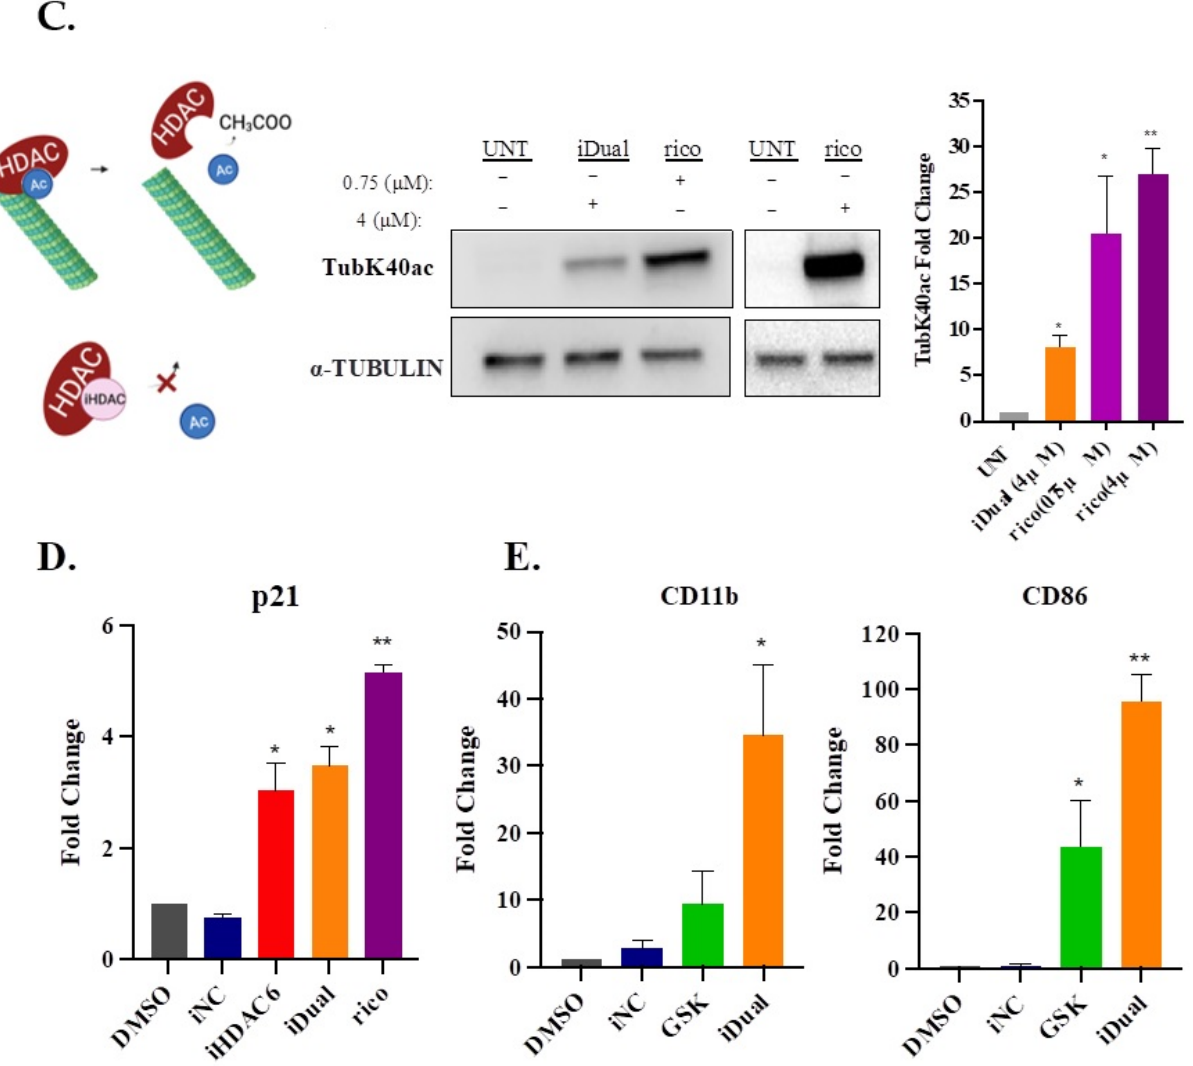
Figure 4. Assessment of biological activity through changes in methylation or acetylation and cell differentiation ( A – C ). Colored graphs illustrate epidrug targets and visualize expected outcomes upon target inhibition. Blue cylinders represent histone octomers ( A , B ) and green tubes represent microtubules ( C ). Fold change in methylation and acetylation levels of LSD1 and HDAC substrates between THP ‐ 1 cells treated with DMSO (control) or inhibitors iDual, iHDAC6, GSK2879552 (4 μ M, 24 h), or ricolinostat (0.75 μ M or 4 μ M, 24 h). Histone methylation, histone acetylation, and α‐ tubulin acetylation levels were quantified from Western blot band intensities (Figure S18). Full Western blot images can be found in Figure S30. ( D , E ) Expression levels of mRNA were measured by RT ‐ qPCR analysis and were normalized to two housekeeping genes, β‐ actin and GAPDH, for p21 and CD11b and CD86. THP ‐ 1 cells were treated with DMSO (control) or compounds (1 μ M, 24 h). Relative expression was determined with the 2( −ΔΔ CT ) method, and the data are represented as the average ± standard error of the mean of two biological repeats with technical duplicates. (* p < 0.05, ** p < 0.01 student t ‐ test). Illustrations were generated in BioRender.com.